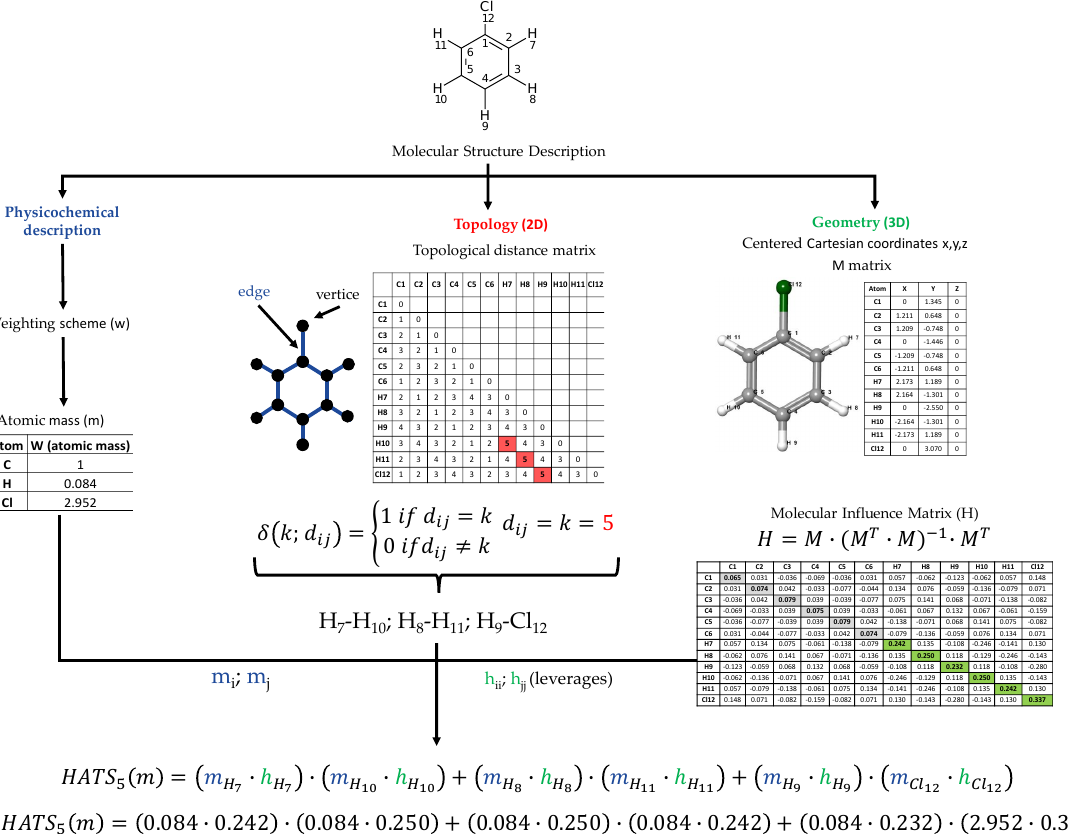
Figure 1. Scheme of HATS5m value calculation for exemplary molecule—chlorobenzene